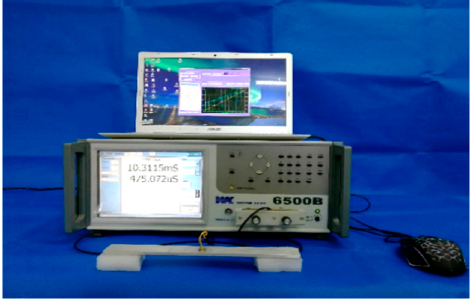
Figure 7. Testing device.